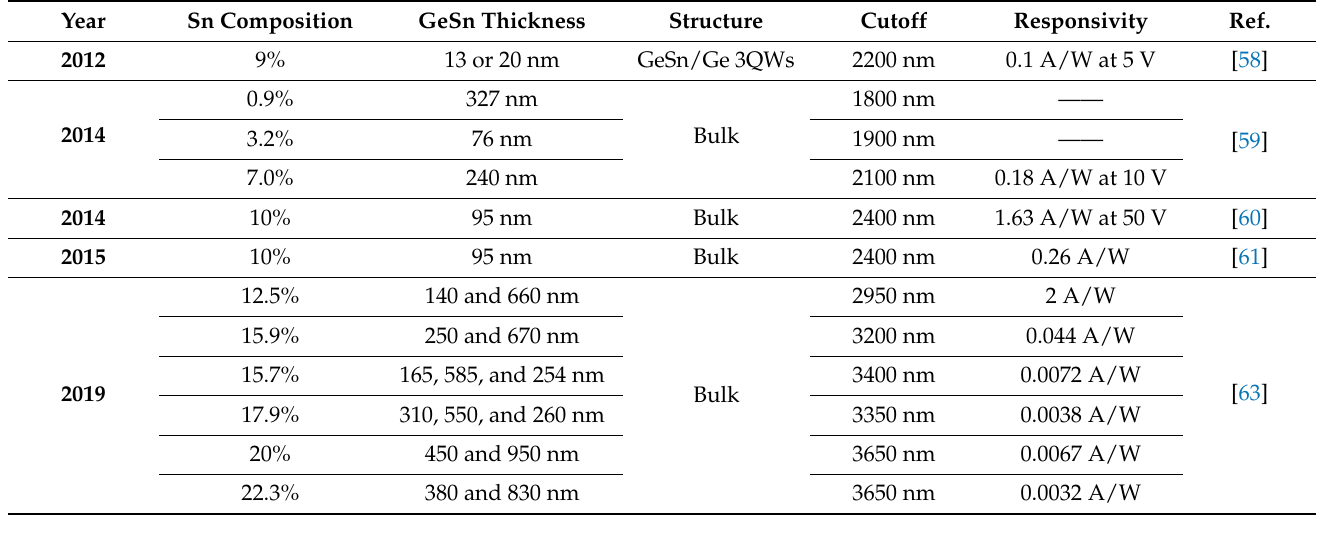
Table 4. Summary of reported GeSn photoconductive detectors in terms of Sn content, GeSn thickness, device structure, wavelength cutoff, and responsivity.